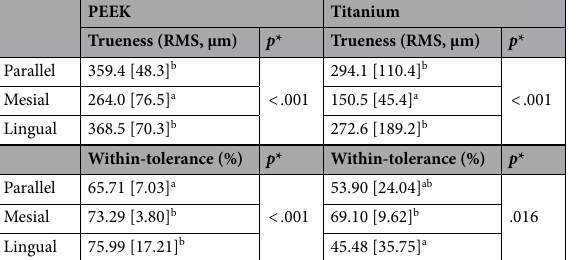
Table 2. Trueness (root mean square, µm) and within-tolerance (%) measurements according to implant angulation and scan body materials. Data are presented as median [interquartile range]. Values with the same superscript letters in each column are not significantly different from each other (Mann–Whitney U test followed by Bonferroni correction for multiple comparisons). PEEK polyetheretherketone, RMS root mean square. *Kruskal–Wallis test.